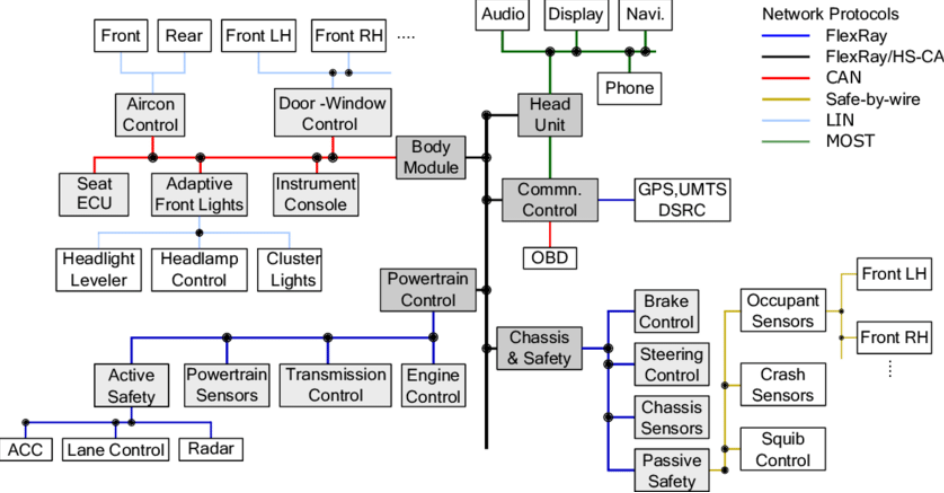
Figure 12. An automotive reference architecture as presented in